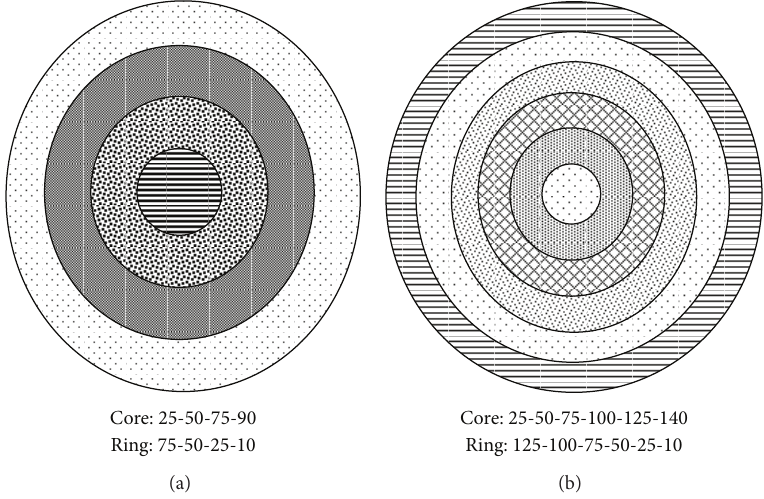
Figure 6: Virtual cutting area in the radial direction for specimens 1 and